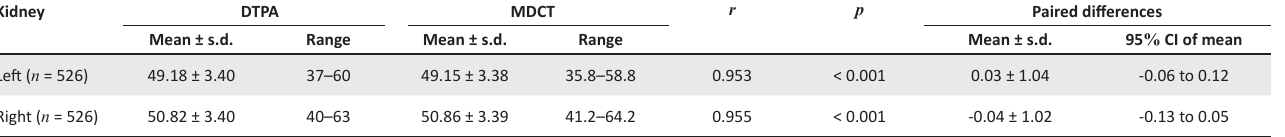
TABLE 2 : Split renal function ( % ) measurements with multidetector computed tomography and diethylenetriaminepentaacetic acid. Kidney DTPA MDCT r p Paired differences Mean ± s.d. Mean ± s.d. Mean ±